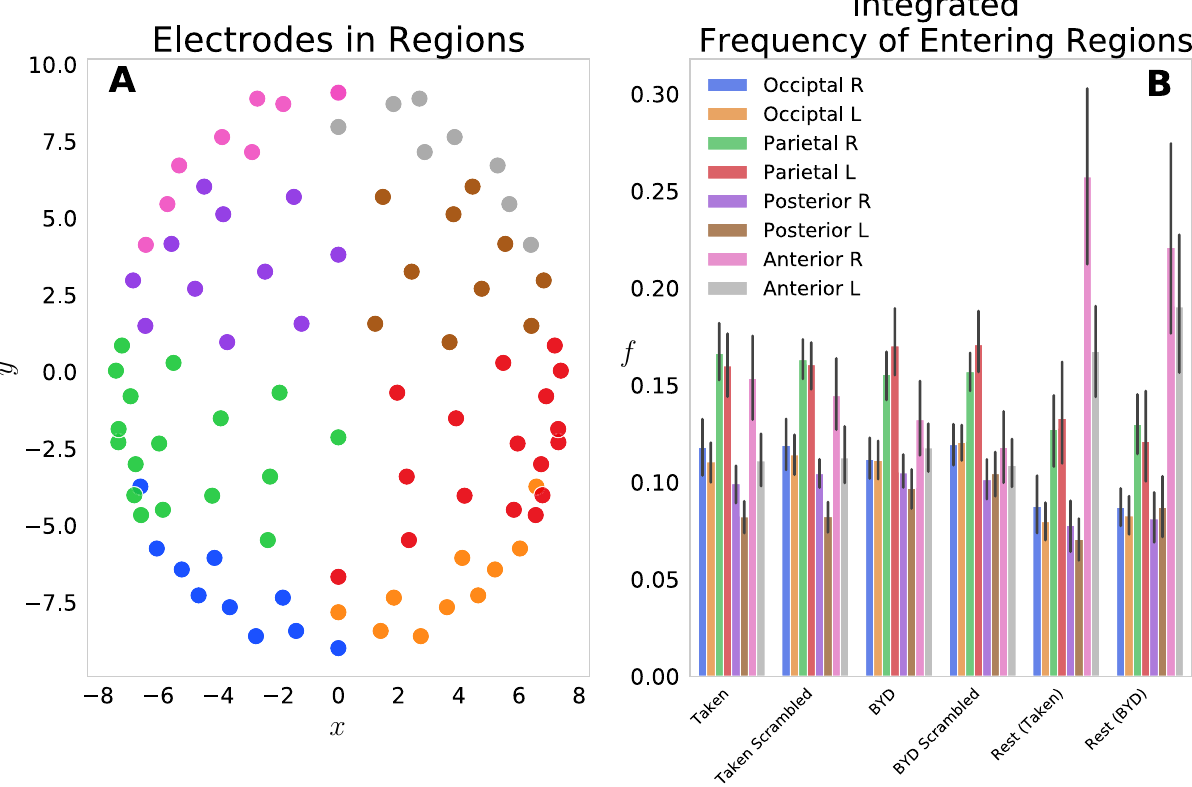
Figure 1. ( A ) Electrode locations for each of the 92 electrodes on the Electrical Geodesics Inc. headcap. Electrodes were projected onto a horizontal plane with the nose in the positive y direction. Electrodes have been colour-coded to display the constituent parts of the 8 groups for the frequency analysis, namely, occipital left (blue)/right (orange), parietal left (green)/right (red), posterior left (purple)/right (brown) and anterior left (pink)/right (grey). ( B ) Histograms representing the frequency of entering each region f G are displayed for the six conditions tested. Significant within stimulus change is present between each of the Anterior Left and Right regions when comparing the pre-stimulus rest and the respective stimulated condition ( P < 0.001, Tukey adjusted.). Error bars display the 1 standard deviation confidence